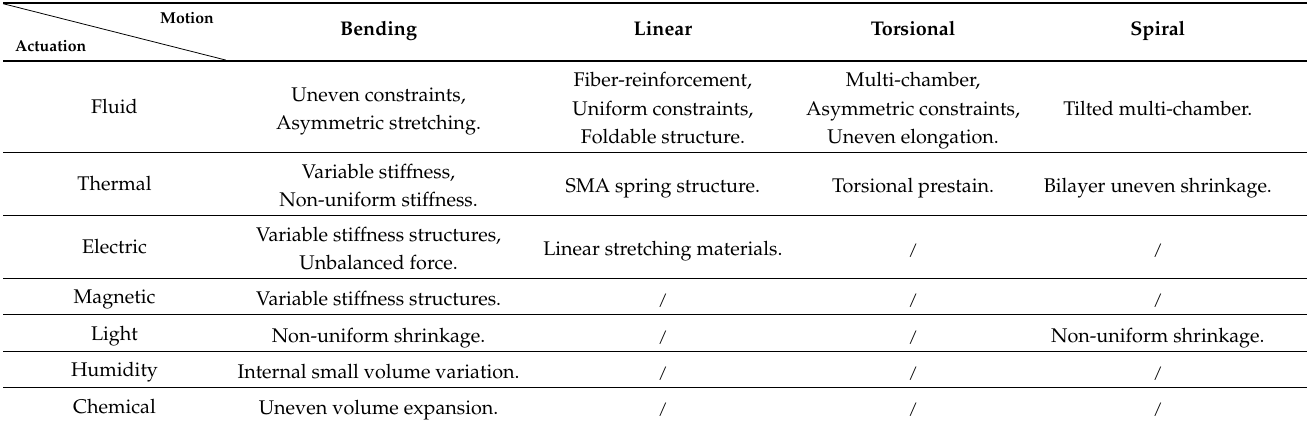
Table 2. Structure design matrix based on actuations and